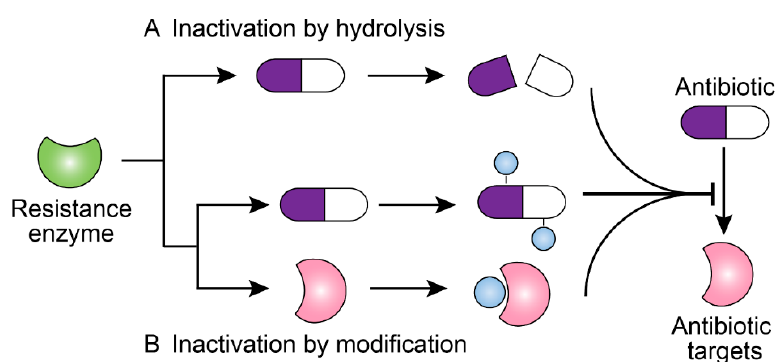
Figure 1. Scheme of antibiotic resistance mechanisms mediated by bacterial resistance enzymes. ( A ) Resistance enzymes hydrolyze the antibiotics and confer resistance. ( B ) Resistance enzymes modify the structure of antibiotics or antibiotic targets, preventing the antibiotics from binding to their targets and conferring